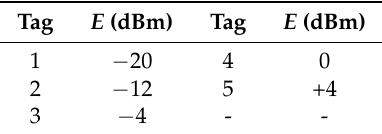
Table 3. Advertising power level for tags.